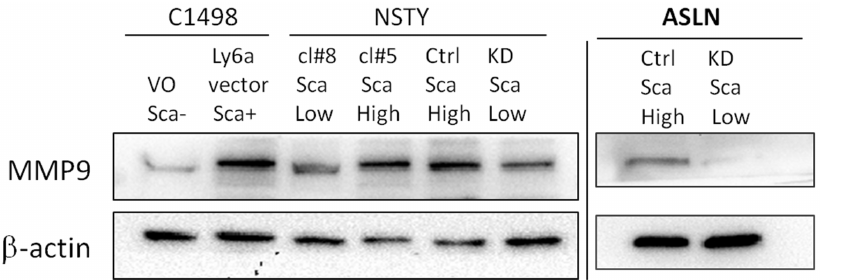
Figure 5. Higher levels of MMP-9 in Ly6a/Sca-1 expressing leukemias. Western blot for MMP-9. For the C1498 leukemia ‘‘VO Sca-’’ is the C1498-vector only control, while ‘‘Ly6a vector Sca + ’’ is C1498-Ly6a/Sca-1. For the NSTY leukemia ‘‘cl # 8 Sca Low’’ is clone 8 that has low levels of Ly6a/ Sca-1, while ‘‘cl # 5 Sca High’’ is clone 5 which has high levels of Ly6a/Sca-1. ‘‘Ctrl Sca High’’ is NSTY leukemia that was treated with a control shRNA vector, while ‘‘KD Sca Low’’ is NSTY after knockdown with an anti-Ly6A/Sca-1shRNA lentivirus vector. For ASLN ‘‘Ctrl Sca High’’ is ASLN leukemia that was treated with a control shRNA vector, while ‘‘KD Sca Low’’ is ASLN after knockdown with an anti-Ly6A/Sca-1shRNA lentivirus vector. ß-actin was used a control for assessing lane loading.